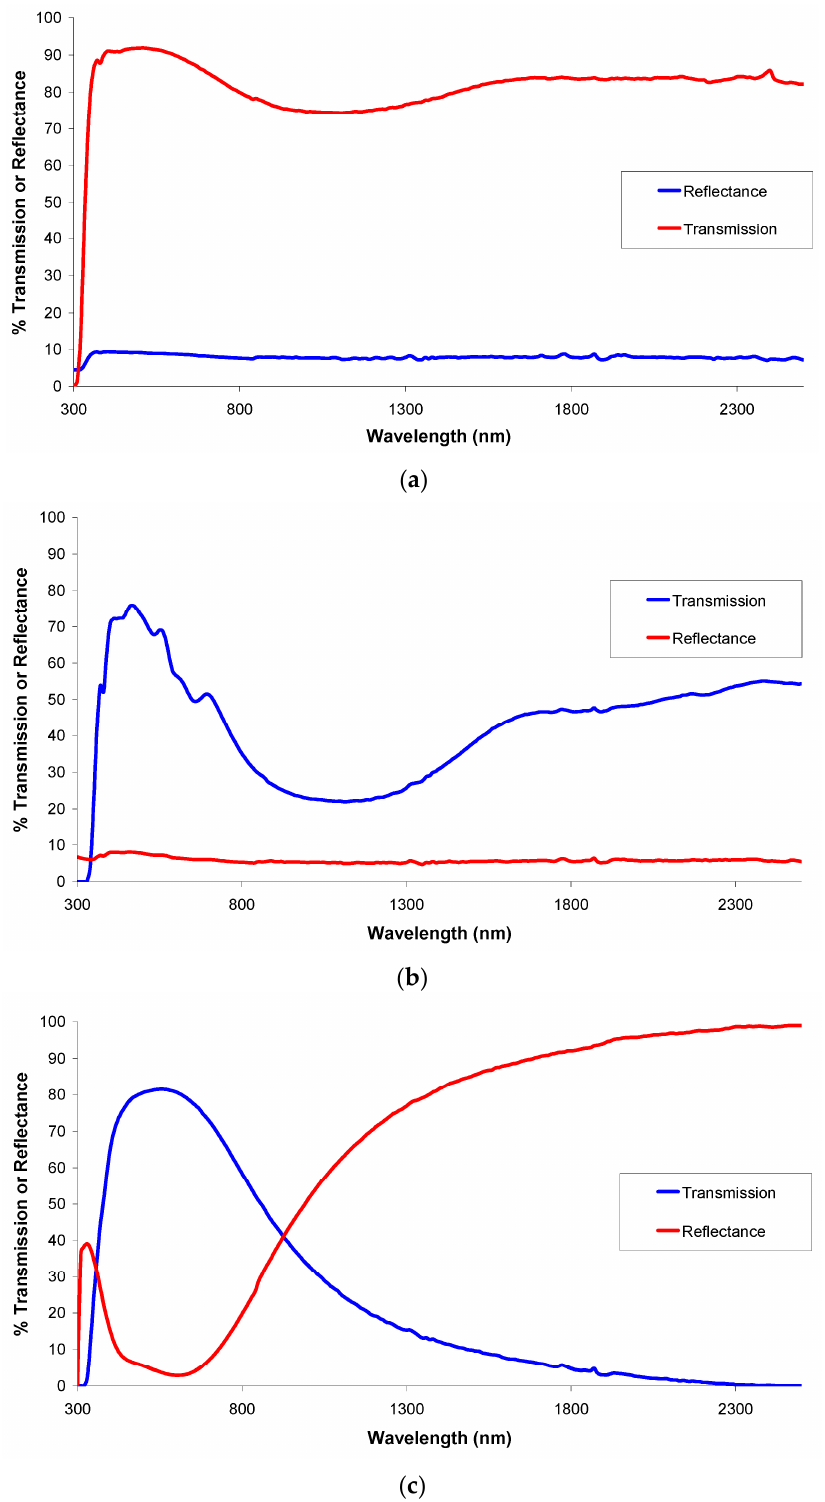
Figure 12. Transmission/Reflectance spectral data for ( a ) clear glass ( b ) absorbing glass (AG) and ( c ) silver sputtered glass (SSG).